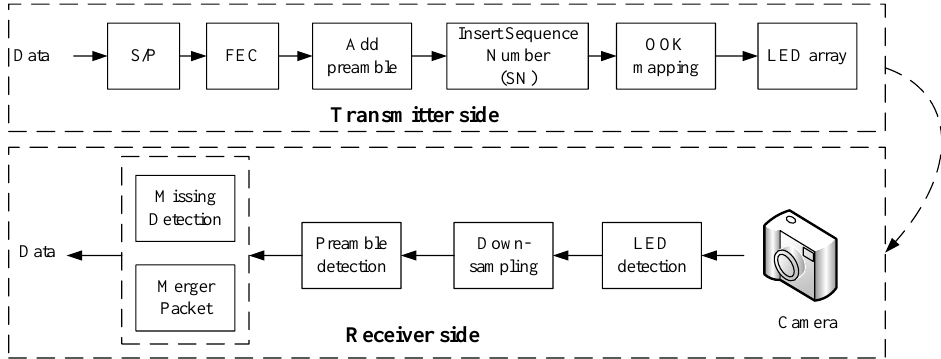
Figure 1. Reference architecture of OCC for an IoT-system-based 2D OOK–MIMO technique using an LED array.